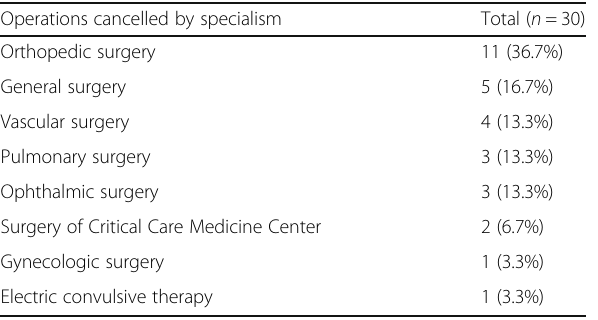
Table 2 Operations cancelled by specialism